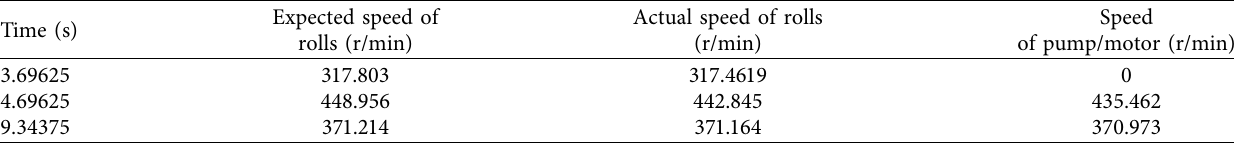
Table 10: Speeds of the recovery pump/motor, the ideal speed, and the actual speed for the roll.